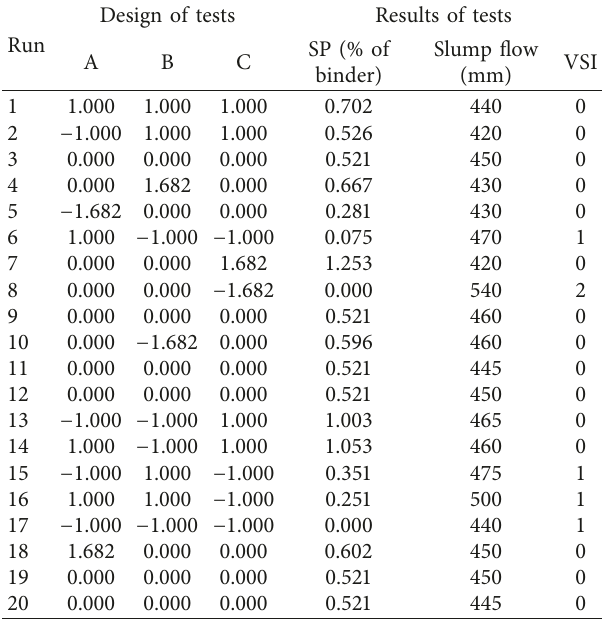
Table 3: Design of tests based on CCD and test